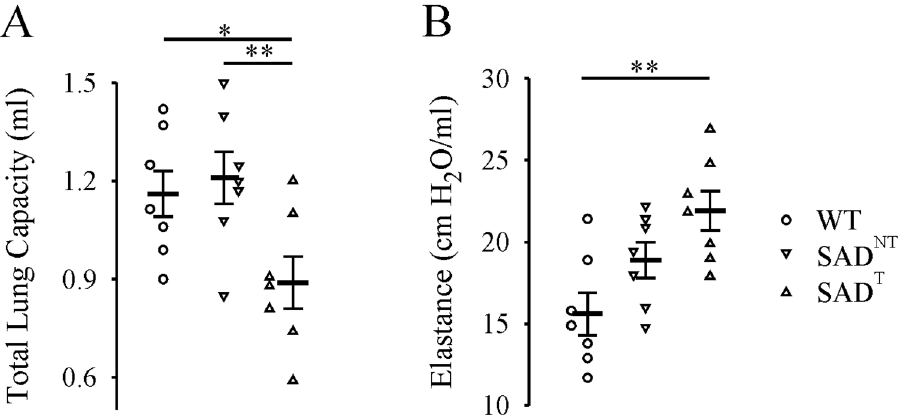
Figure 6. Lung function measured by Flexivent system. ( A) Total lung capacity (TLC) and (B) dynamic elastance were significantly increased in SAD mice with tachypnea (SAD T ), but not in SAD mice without tachypnea (SAD NT ) group, relative to WT. * p < 0.05; ** p < 0.01 using one-way ANOVA Holm-Sidak